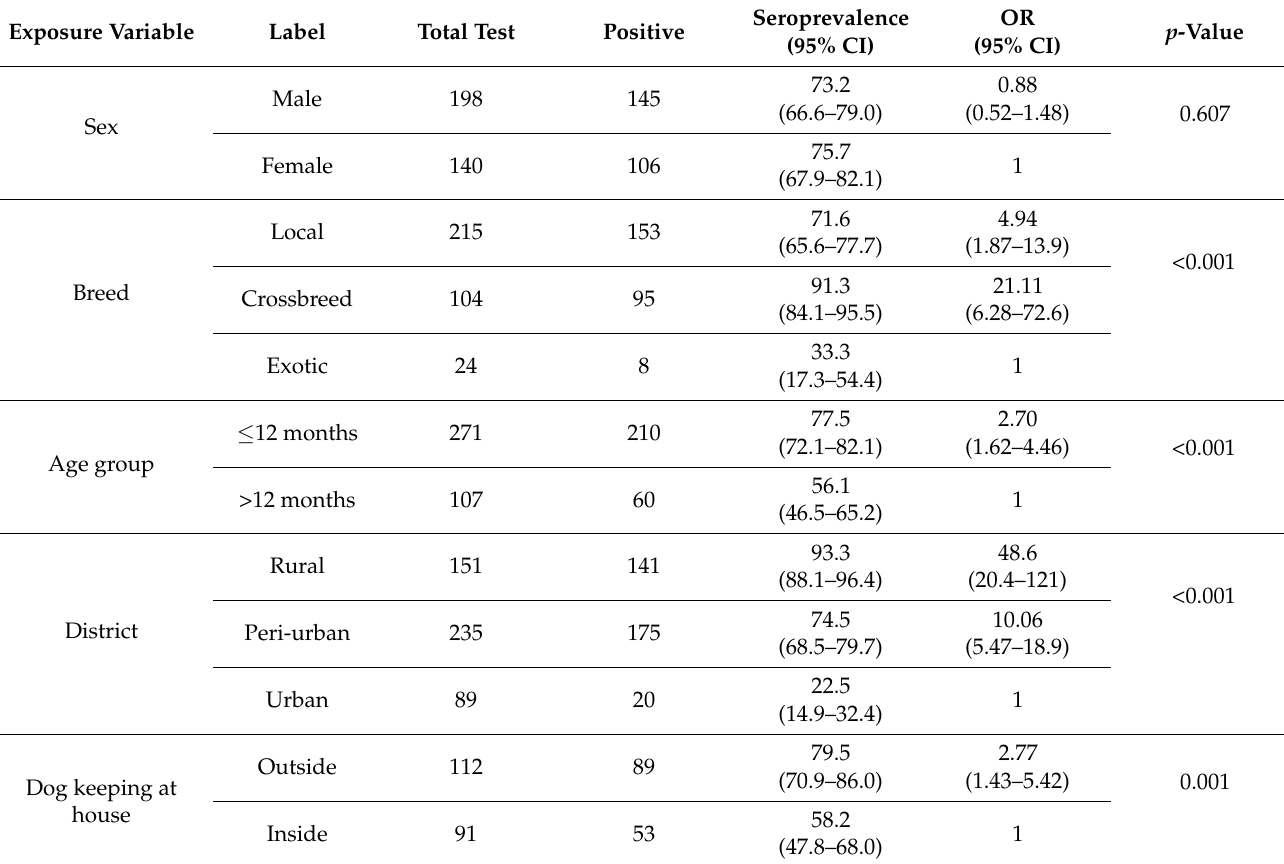
Table 2. Results from univariable analysis showing the association between seropositivity of dogs and exposure variables.